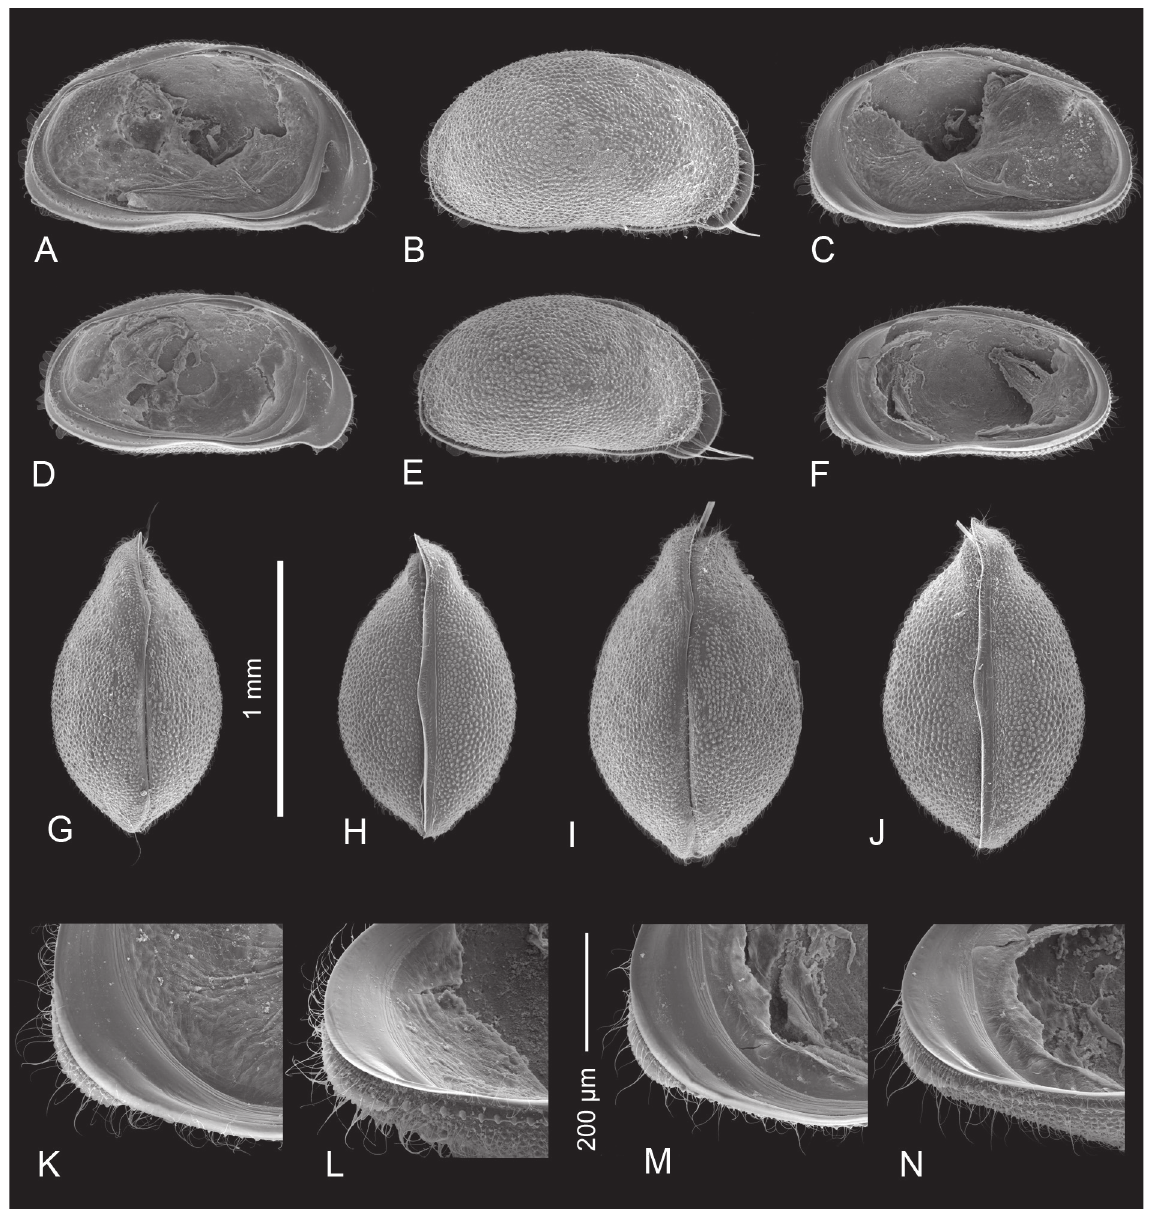
Fig. 7. Bennelongia koendersae sp. nov. (all from type locality: claypan at strelley station, Pilbara, WA). A . LVi (♀, OC3376). B . CpRL (♀, WAMC55618). C . RVi (♀, OC3376). D . LVi (holotype ♂, WAMC55611). E . CpRL (♂, WAMC55613). F . RVi (♂, WAMC55611). G . CpD (♂, WAMC55613). H . CpV (♂, specimen lost). I . CpD (allotype ♀, WAMC55612). J . CpV (♀, WAMC55617). K . rVi, detail anterior margin (♀, OC3376). L . RVi, tilted, detail anterior margin (♀, OC3376. M . rVi, detail anterior margin (♂, WAMC55611). N . RVi, tilted, detail anterior margin (♂, WAMC55611). Scale = 1 mm for A–J; 200 µm for